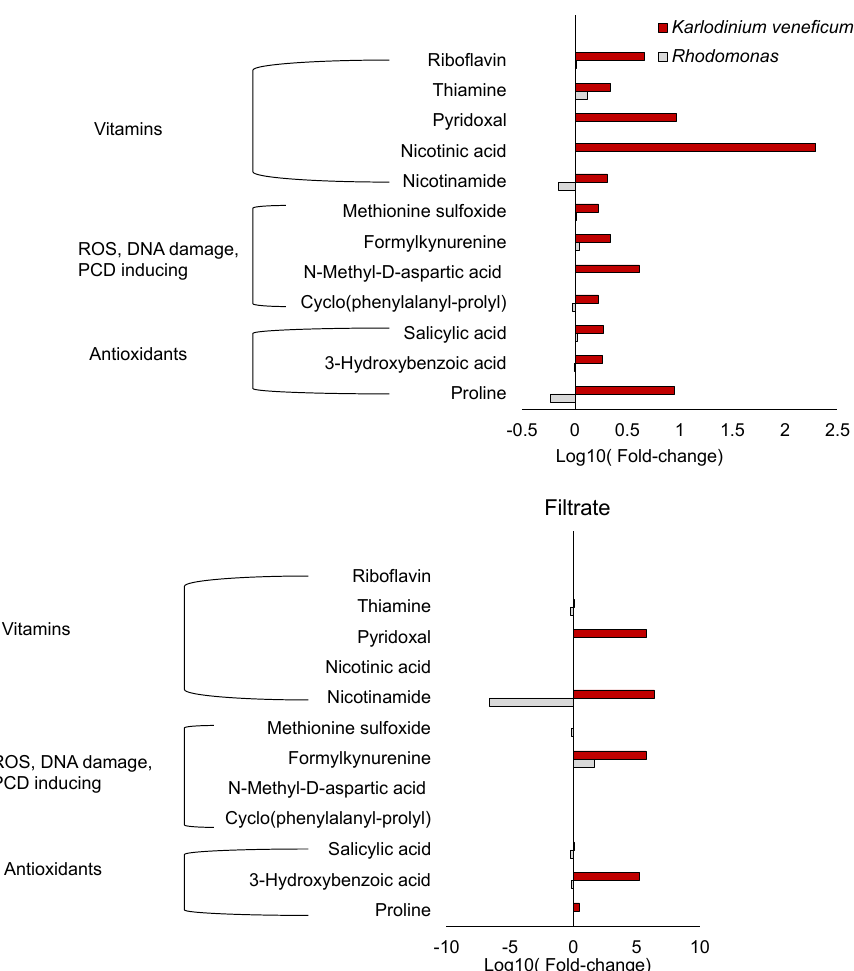
Figure 4. Relative changes in B vitamins, metabolites involved in ROS production, DNA damage, and/or PCD, and antioxidants that increased in the cell pellets of Karlodinium veneficum but not Rhodomonas . Figures represent the log10 transformed fold-change of relative concentrations of these compounds in the cell pellets ( upper ) and the filtrate ( lower ) of the algicide treatment over the con- trol (with no algicide addition). The analysis was based on the averaged peak areas (normalized to cell densities for the cell pellets) of duplicate samples; error bars were not included.